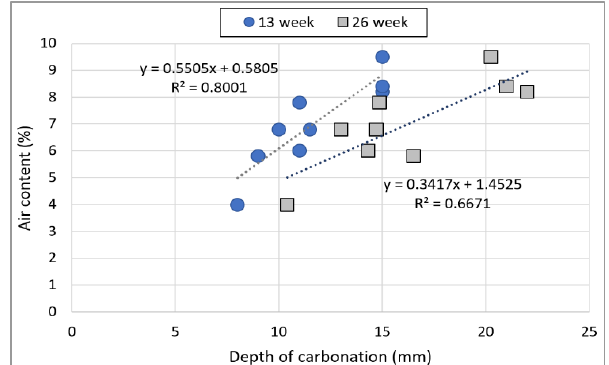
Figure 14. Relationship between the depth of carbonation and air content.